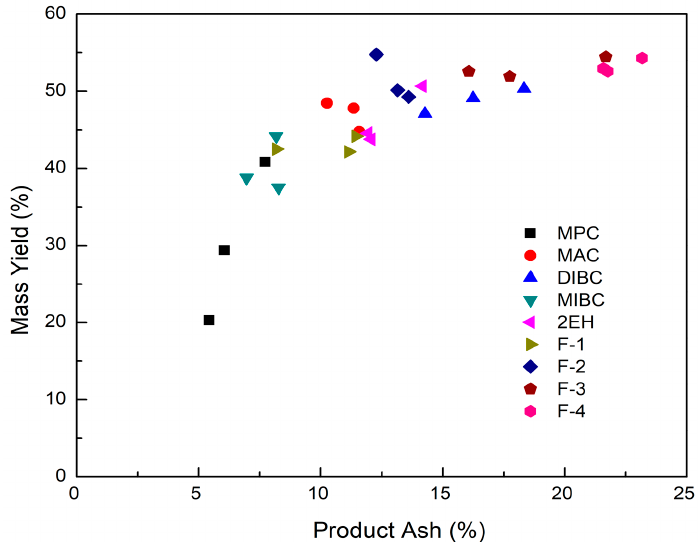
Figure 10. Mass yield of evaluated frothers as a function of clean coal ash.